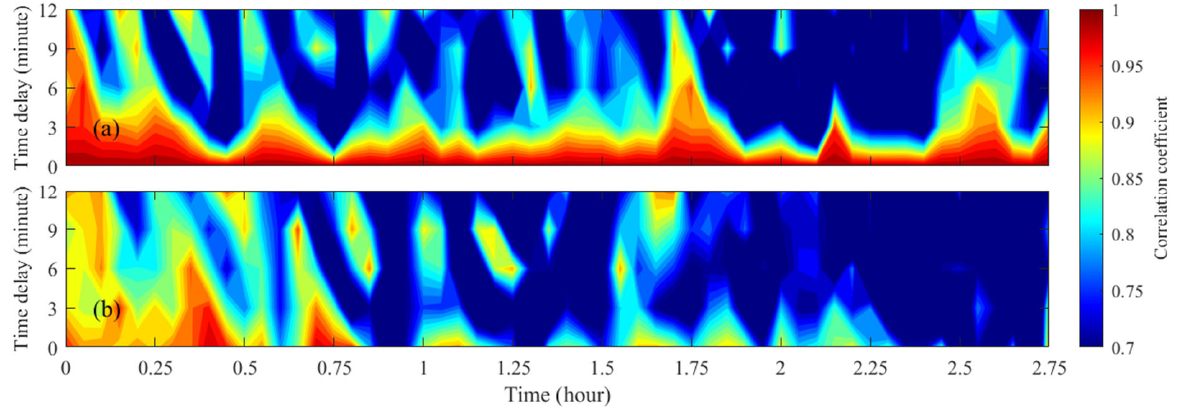
Figure 11. Contour plots of correlation coefficients vs. time and time delay measured in the experi- ment at two different depths: ( a ) 31.4 m and ( b ) 61.6 m.